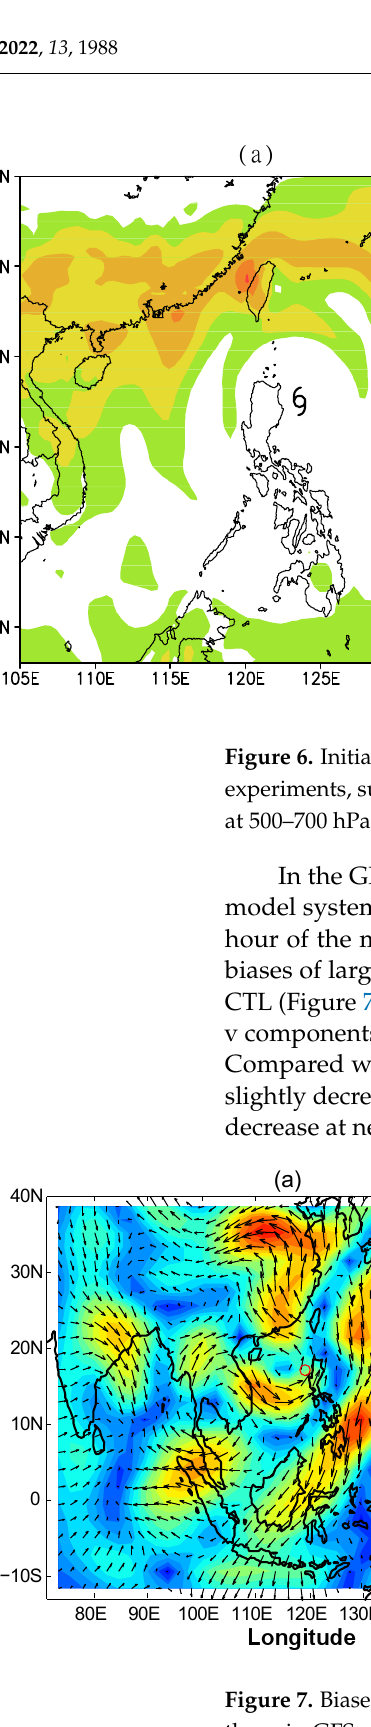
Figure 8. Vertical profile of 5 ‐ day mean RMSEs of large ‐ scale ( a ) u and ( b ) v components for each experiment against the corresponding components in the GFS analysis, averaged over all grids in the inner domain. (unit: m s − 1 ).